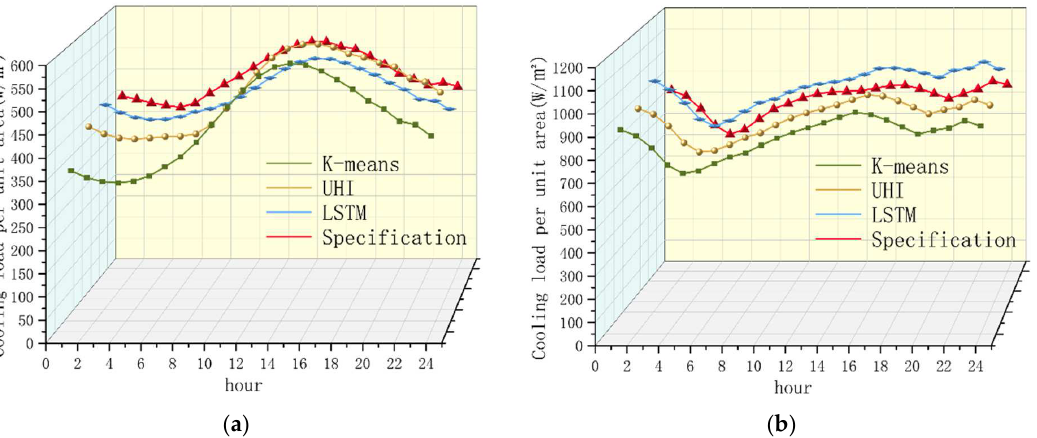
Figure 17. The unit area of inpatient buildings in Beijing ( a ) and Shanghai ( b ) is subjected to hourly cooling load.